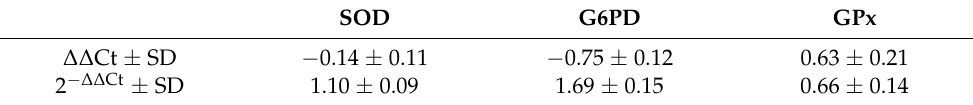
Table 1. Quantification result of target genes by real-time PCR by the delta Ct